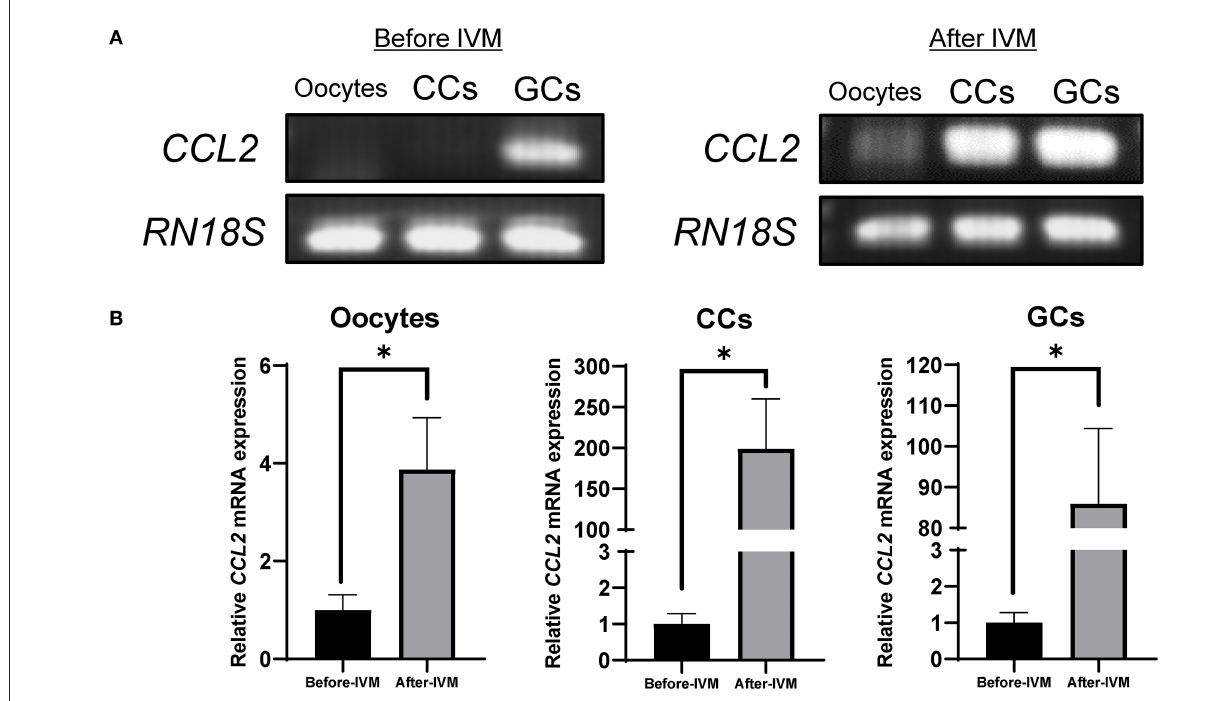
FIGURE1 Expression of CCL2 in porcine oocytes, CCs, and GCs was determined by RT-PCR (A) and qPCR (B) . CCL2 mRNA levels were detected in porcine follicular cells, before and after IVM. RN18S served as a ubiquitously expressed gene control. The experiment was conducted three times. * p <